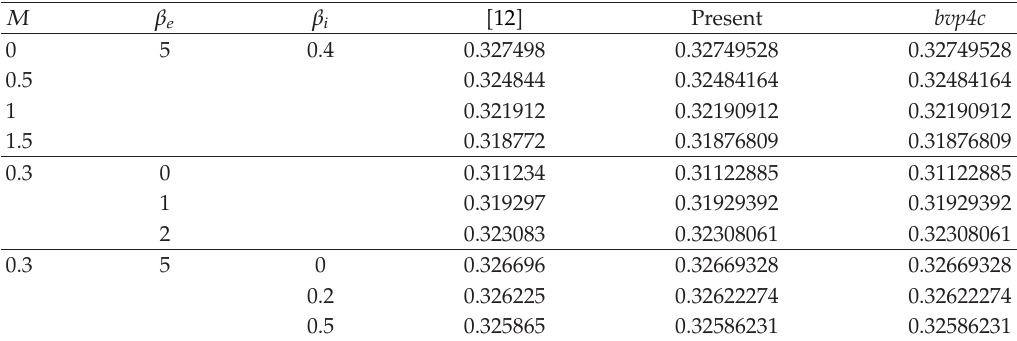
Table 2: The wall shear stresses C fx (cid:8) (cid:6) 1 (cid:9) N 1 (cid:7) f (cid:4)(cid:4) (cid:6) 0 (cid:7) for various values of k p , N 1 , β e , and β i at M (cid:8) 0 . 3,